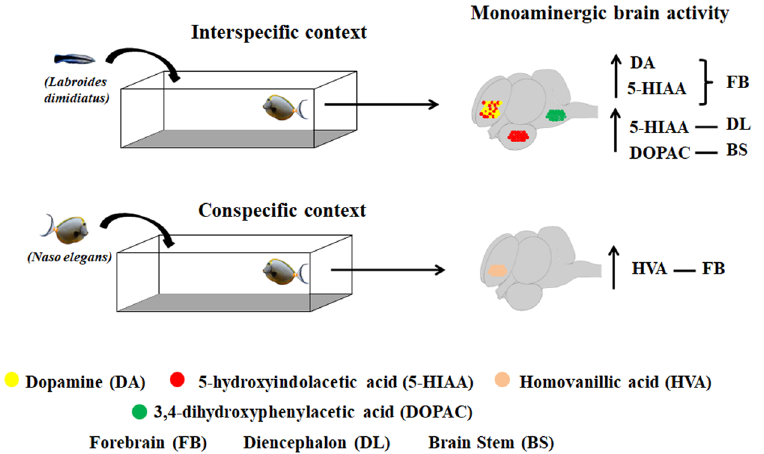
Figure 3. Monoaminergic brain activity in interspecific and conspecific contexts. Labroides dimidiatus and Naso elegans partial images were adapted from photos taken by